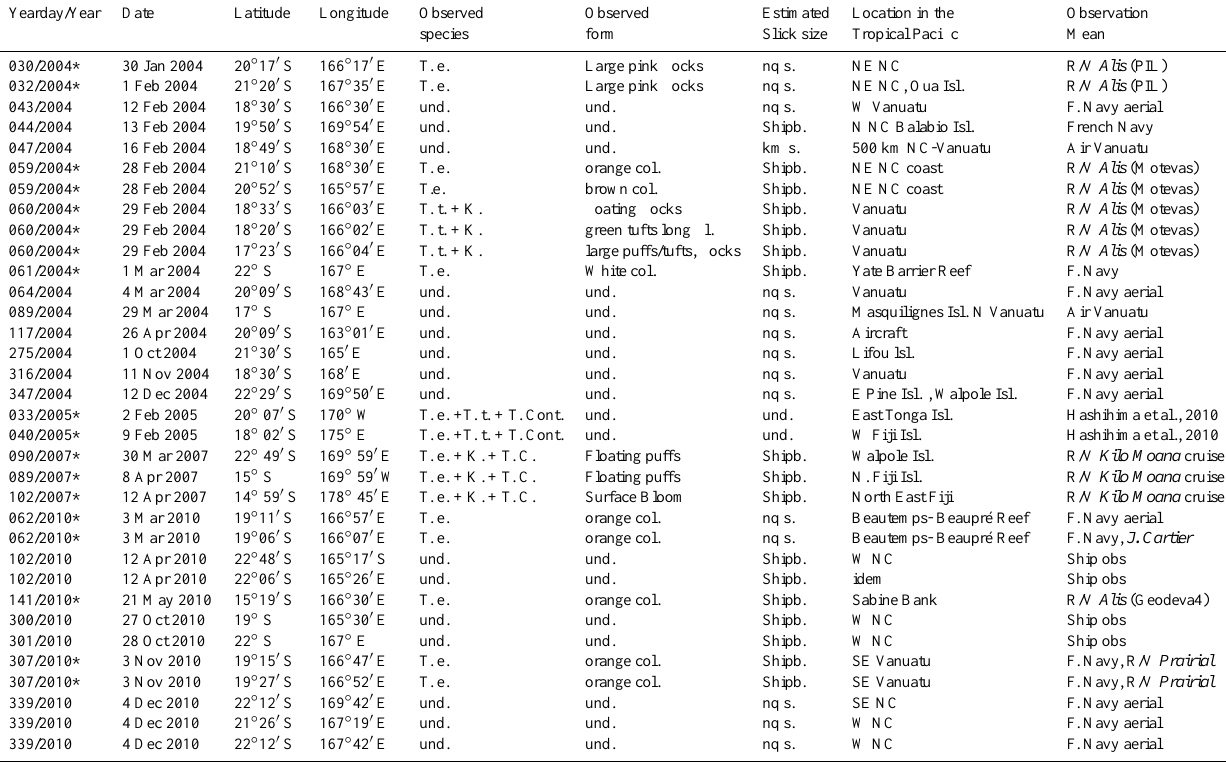
(Table 1). Surface blooms were rarely detected in situ dur- April, remnant slicks were seen nearby Lifou island at the east of the “Grande terre” of New Caledonia (Table 1). Sur- face slicks were also observed in summer during a water- column observational program in the Loyalty Channel (12 October 2001, 5 February 2003 and 2004, see Tables 1